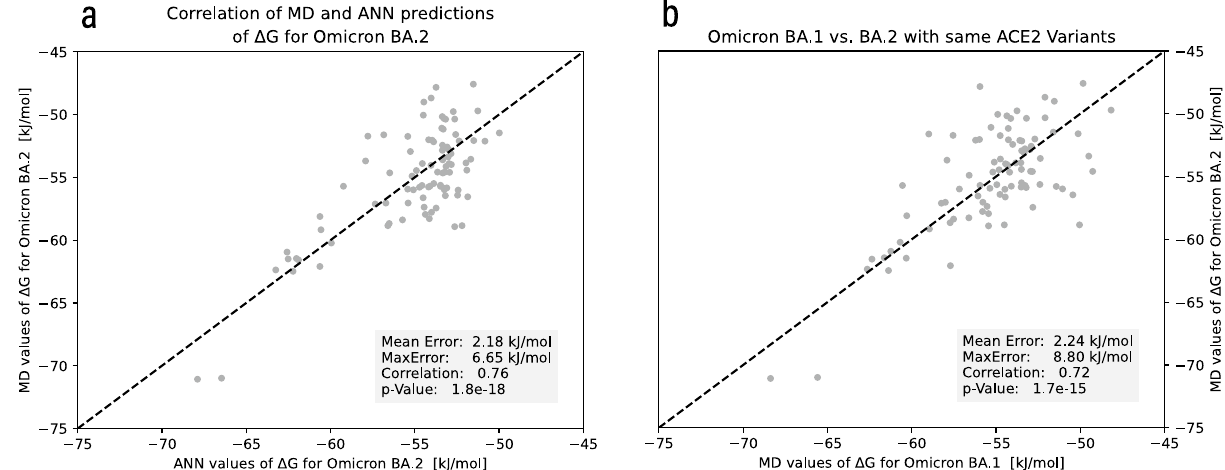
Figure 4. Basic comparison to gauge the potential of the ANN prediction model. ( a ) Correlation plot between Gibbs free-energy values (Δ G ) from MD simulation and ANN model prediction for SARS-CoV-2 Omicron BA.2 on a set of hACE2 variants (Pearson correlation = 0.76). ( b ) Correlation of Omicron BA.1 and BA.2 Δ G values on the same hACE2 receptors (Pearson correlation =